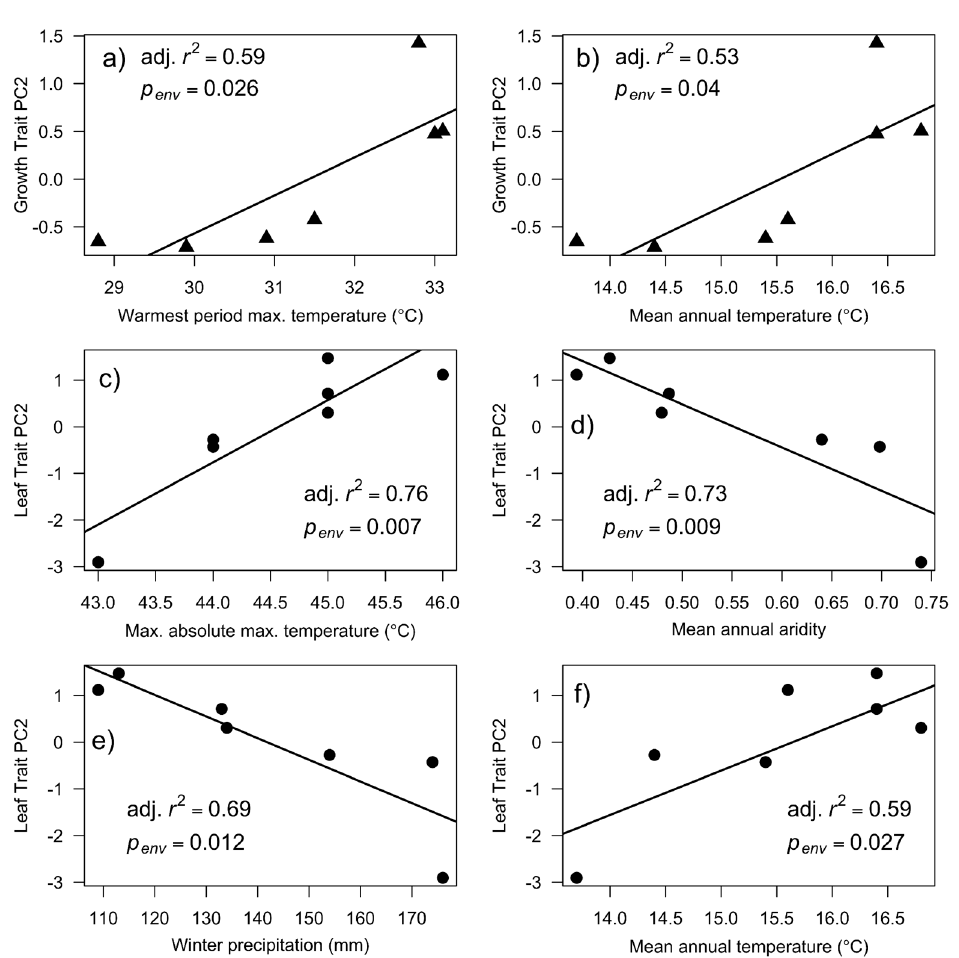
Figure 2. Example associations between climate and provenance level trait principal component (PC) axes in Eucalyptus microcarpa (Grey box). ( a–b ) Climate associations with second growth trait PC, reflecting primarily (increasing) size ratio and (decreasing) DBH. ( c–f ) Climate associations with second leaf trait PC, reflecting predominately (decreasing) leaf density and (increasing) SLA and to a lesser extent, (increasing) leaf thickness and leaf length. Adj. r 2 = adjusted r 2 of linear regression; p env = significance of environmental component of the linear model (see Table 4). Refer to Table S5 for further details on trait contributions and correlations to PC axes.